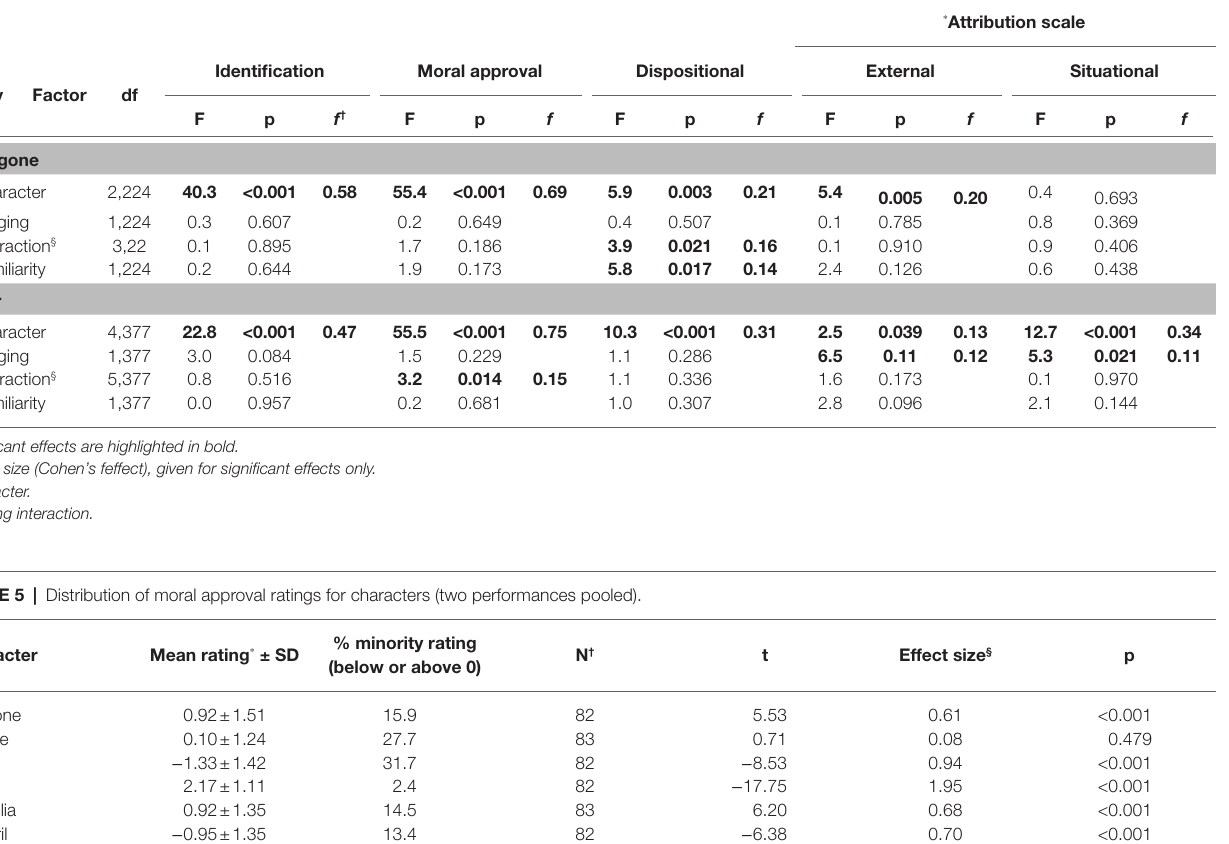
TABLE 4 | MANOVAs comparing ratings across characters and performances (conventional versus reversed characterisation) for each play, with Familiarity as a covariate.